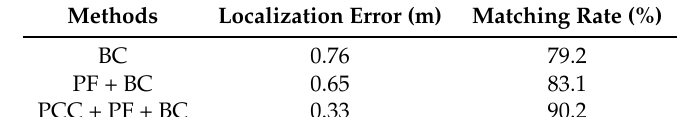
Table 2. Comparison of experimental results based on different approaches.